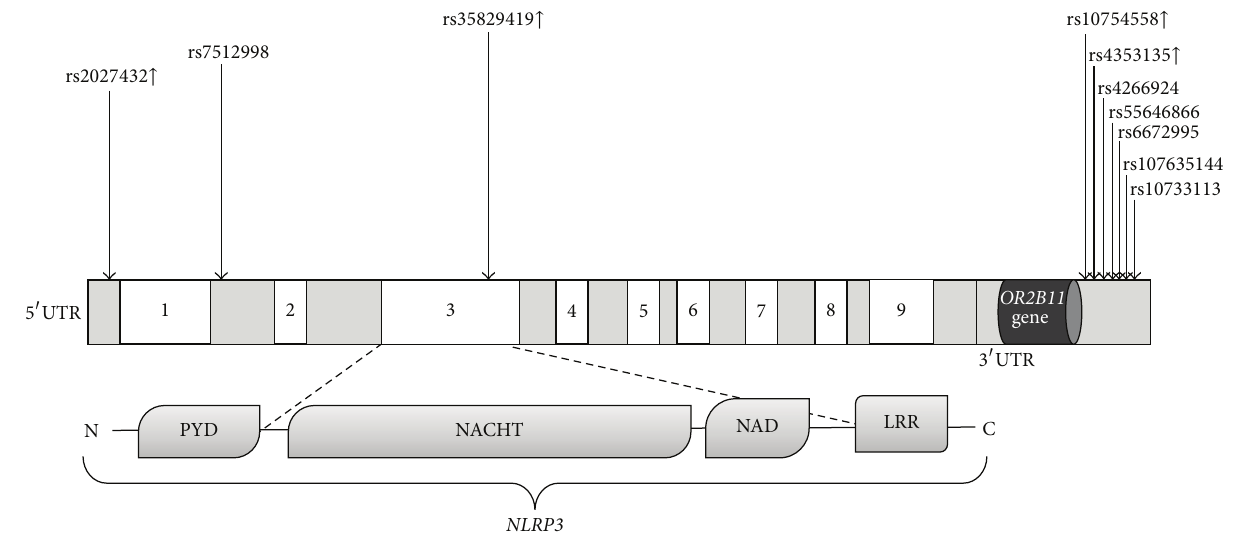
Figure 1: Schematic representation of polymorphisms in the NLRP3 gene investigated in relation to inflammatory diseases. Exons of the NLRP3 gene are displayed as white boxes (not to scale). Upregulation of NLRP3 is indicated as ( ↑ ) beside the SNP rs number; polymorphisms with unknown biological function are not labeled. The lower panel represents the different domains of NLRP3: PYD, pyrin domain; NAD, NACHT associated domain; and LRR, leucine-rich repeat.